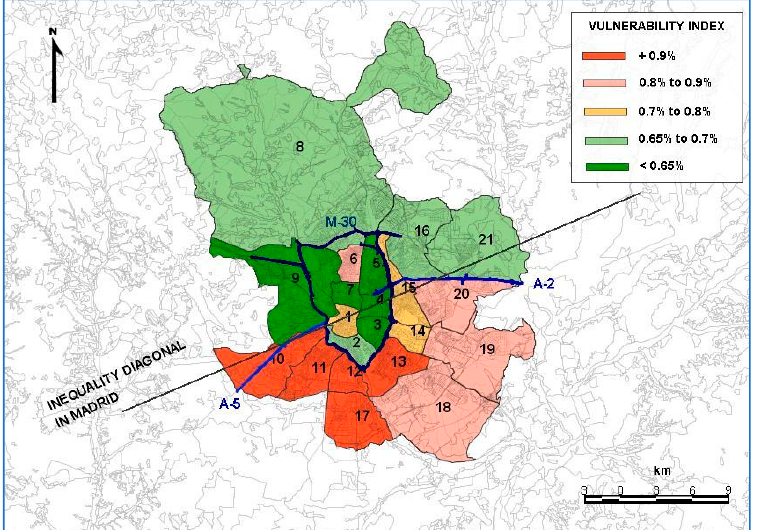
Figure 1. Geographical and social differences in Madrid. Source: Own elaboration, based on the document “Metodología para la elaboración del Índice de Vulnerabilidad Territorial de barrios y distritos de Madrid y Ranking de Vulnerabilidad (2018)” [29]. 1—Centro; 2—Arganzuela; 3—Retiro;